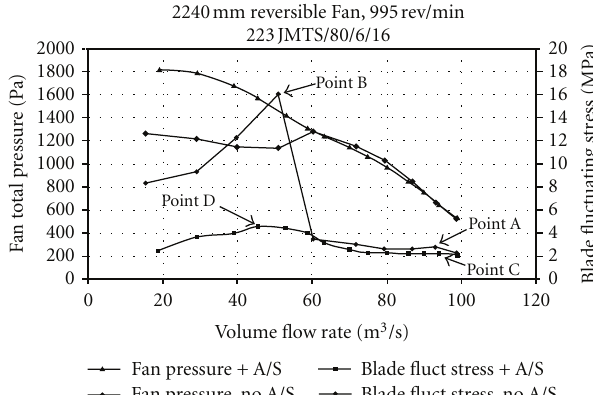
Figure 3: Stall characteristics of the test fan with and without a fitted stabilisation ring.